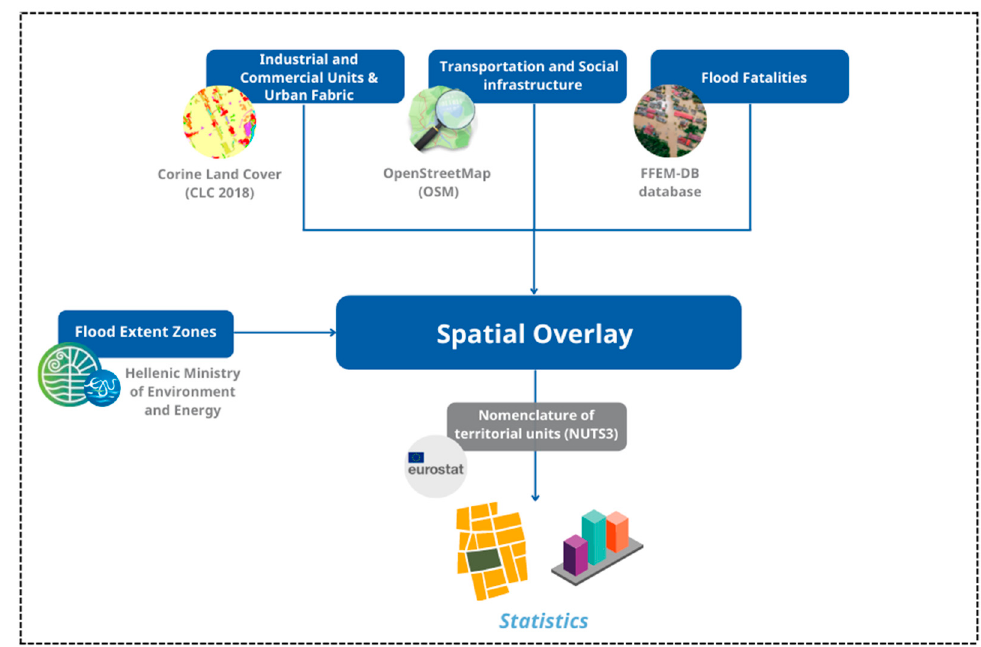
Figure 2. The overall workflow of the methodology. Table 1. Summary of the input datasets and sources used in this study.